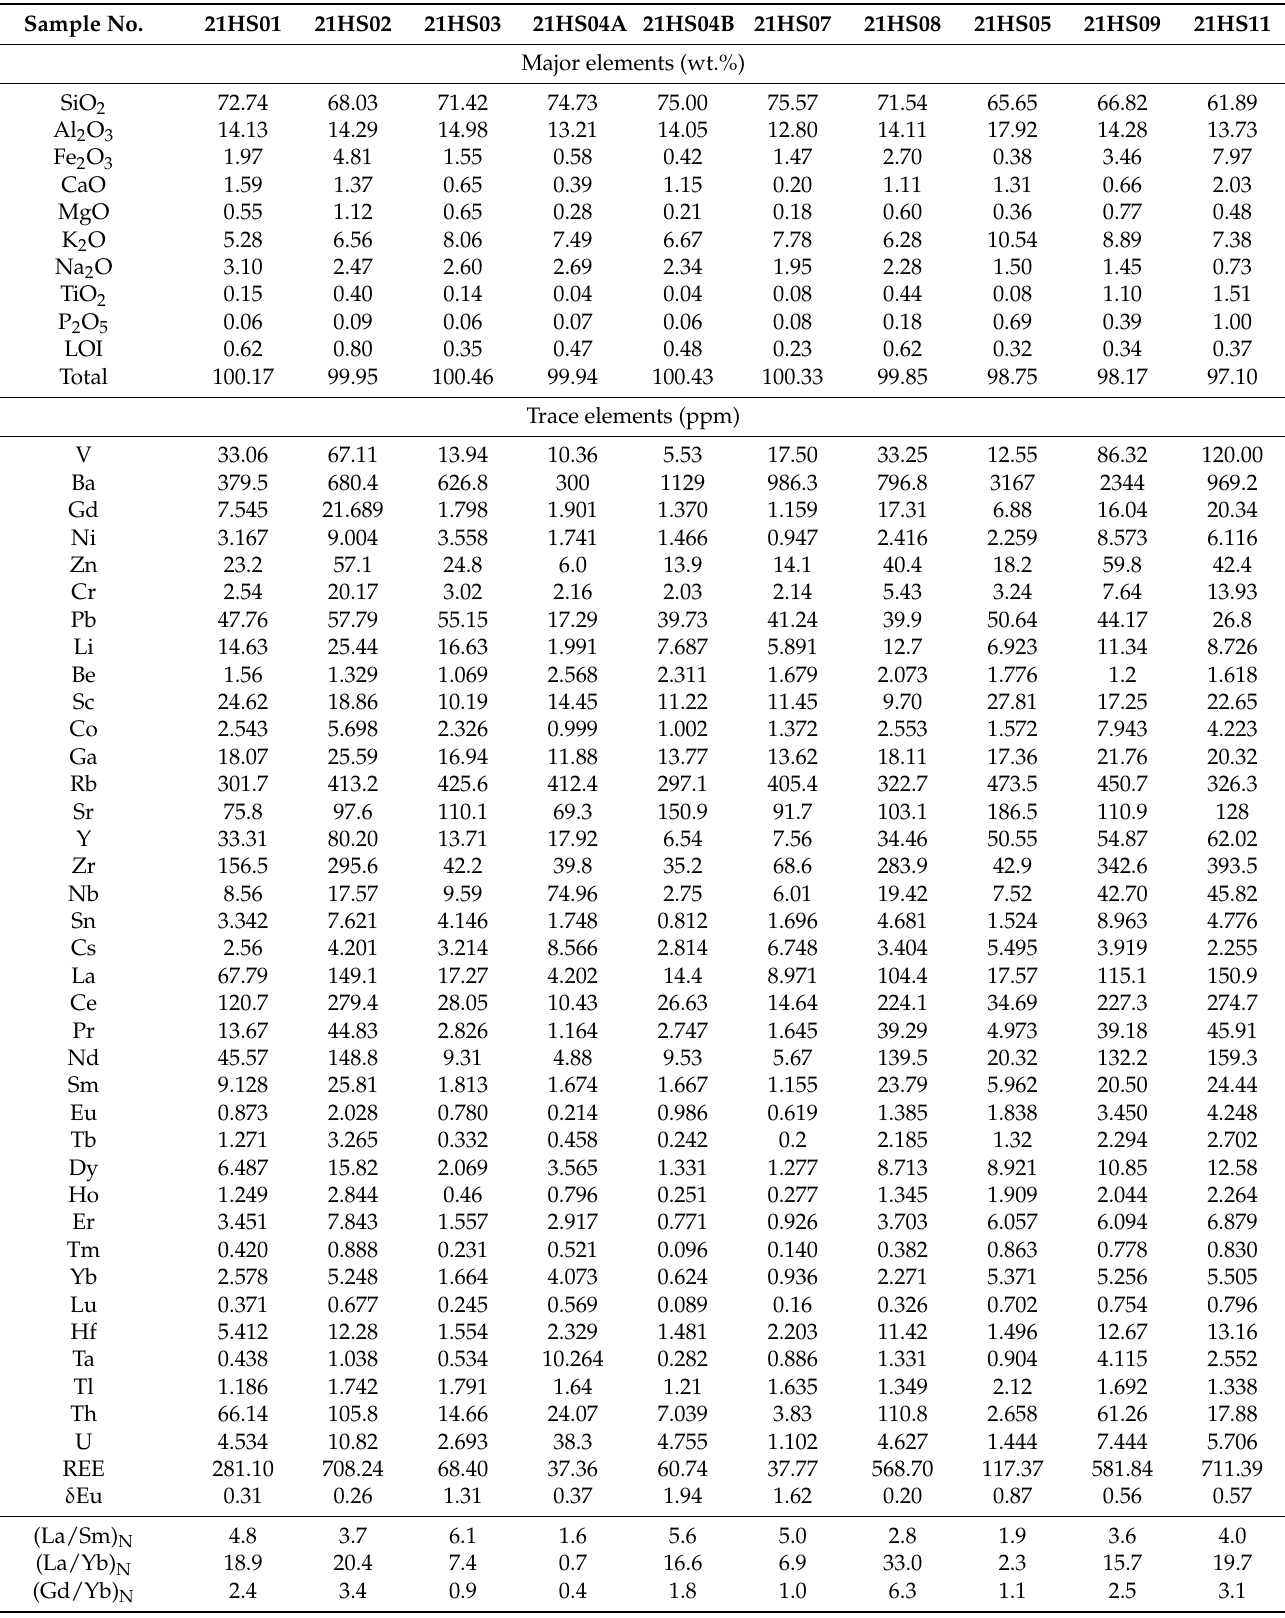
Table 1. Whole-rock geochemical data for studied rock types from the Abbabis Metamorphic